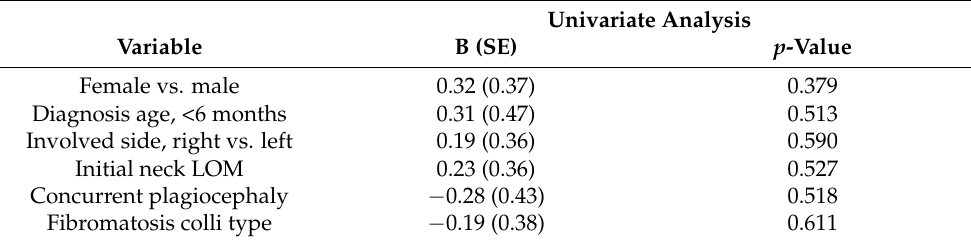
Table 5. Logistic regression analysis of factors associated with pelvic malalignment